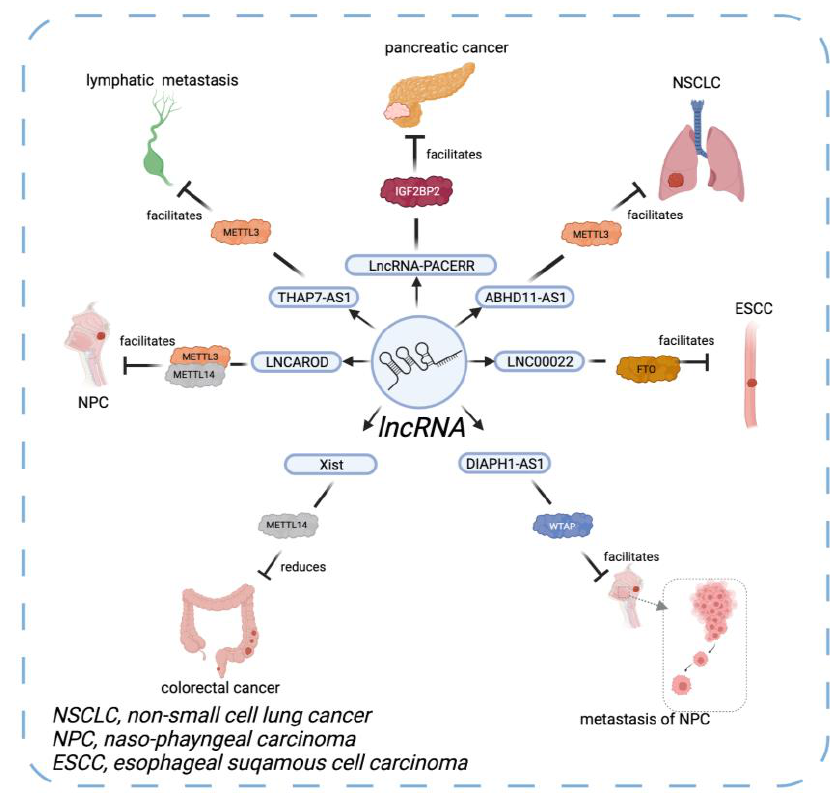
Figure 2. The interaction between lncRNA and its m6A regulators.